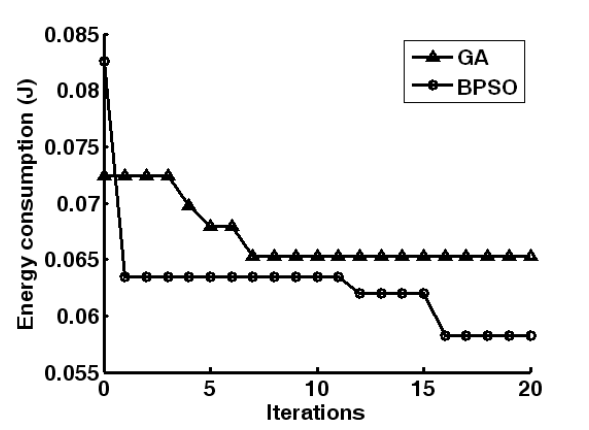
Figure 12. Convergence curves of energy metric obtained by BPSO and GA in sensor node selection